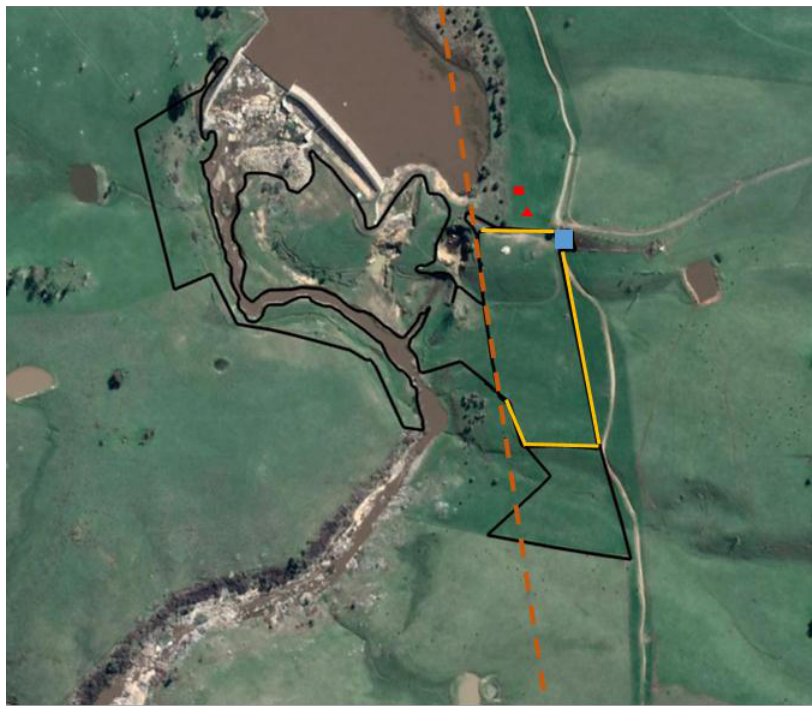
Figure 1. A satellite image (Google Earth ® ) of the commercial riparian zone. The dark tracks indicate the area available to the cattle as constrained by physical fences or topography. The dashed orange line indicates the single virtual fence line implemented for ten days. The solid yellow lines indicate the inclusion zone that the cattle had access to when the virtual fence line was in place and the blue square indicates the position of the water trough when river access was excluded. The red triangle indicates the position of the base station, and the red square indicates the position of the observers.